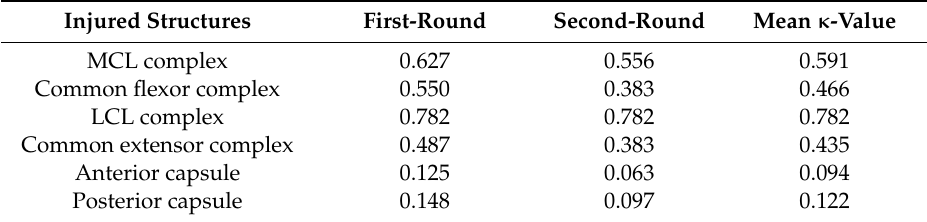
Table 2. Interobserver agreement between radiologist 1 and 2 per injured structures.